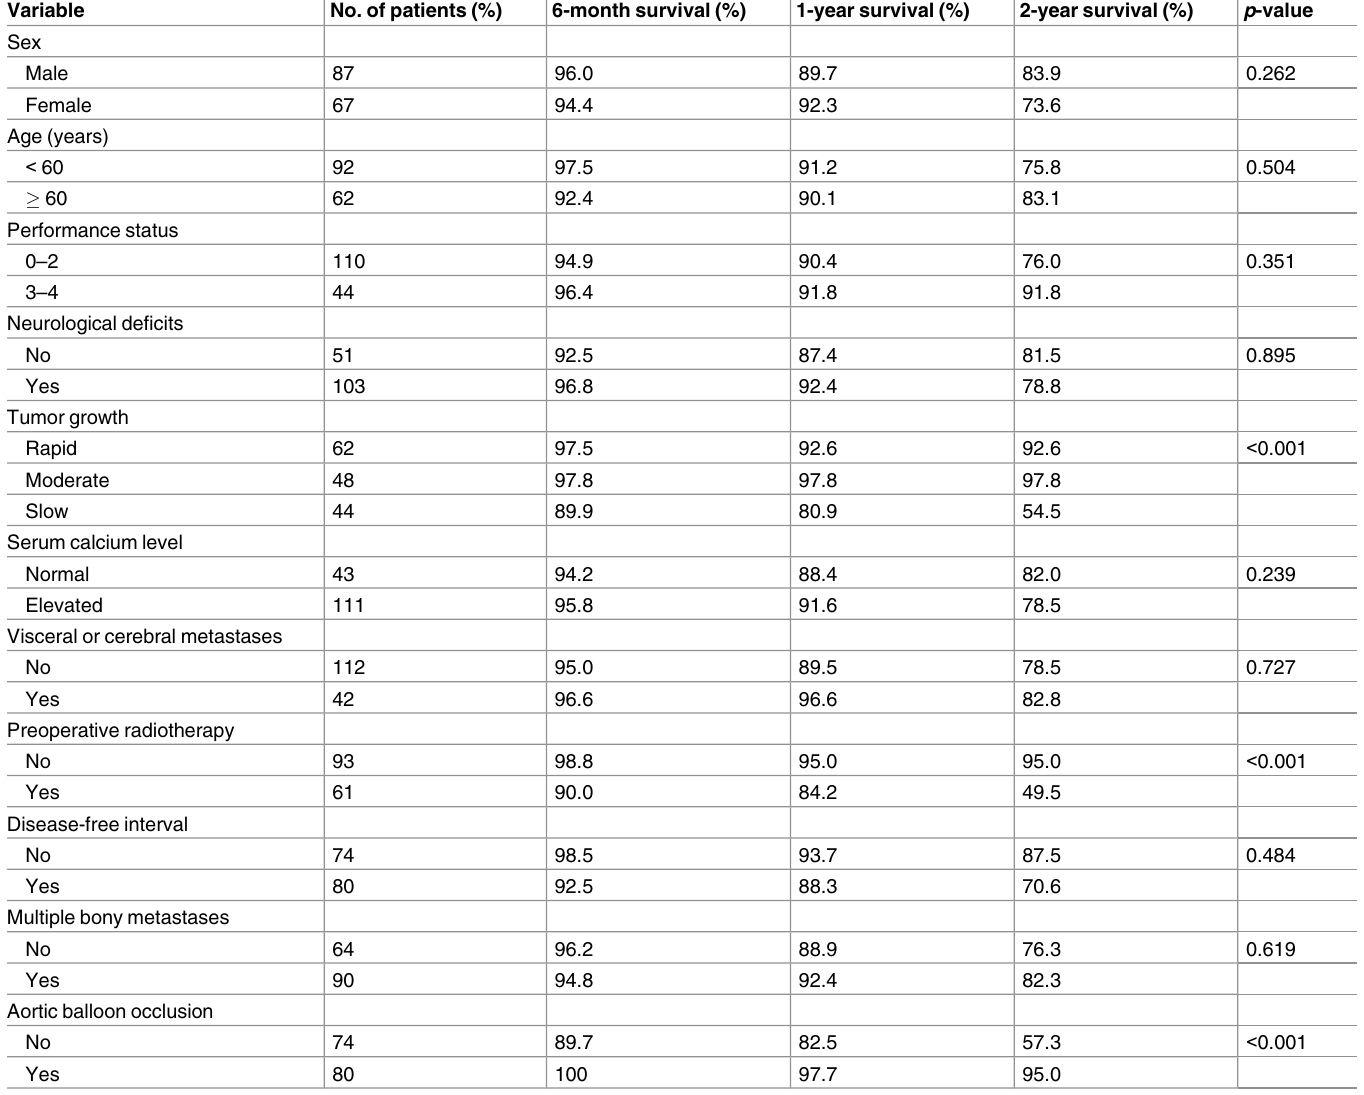
Table 2. Univariate Analysis of Potential Prognostic Factors for Local Control Rate in the Study